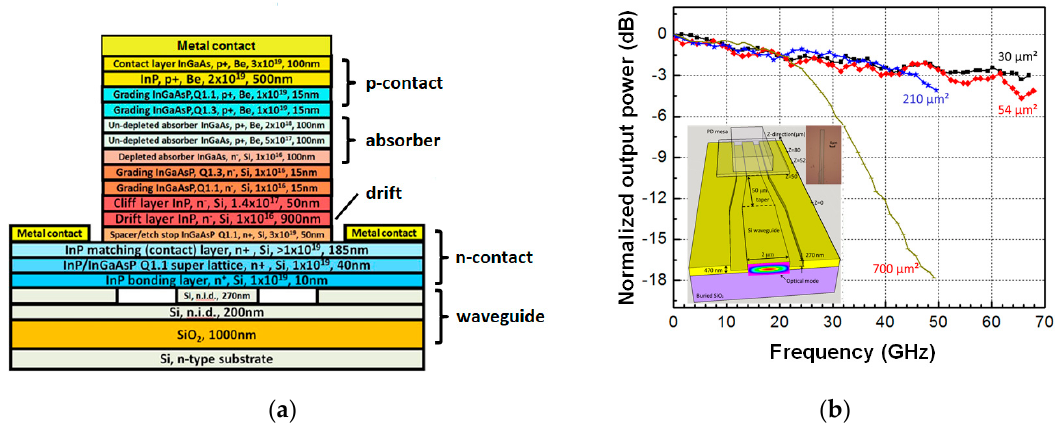
Figure 12. ( a ) Device structure of heterogeneous MUTC PD on silicon-on-insulator (SOI); ( b ) Measured frequency responses for PDs with different area. The inset shows a schematic view of the PD.